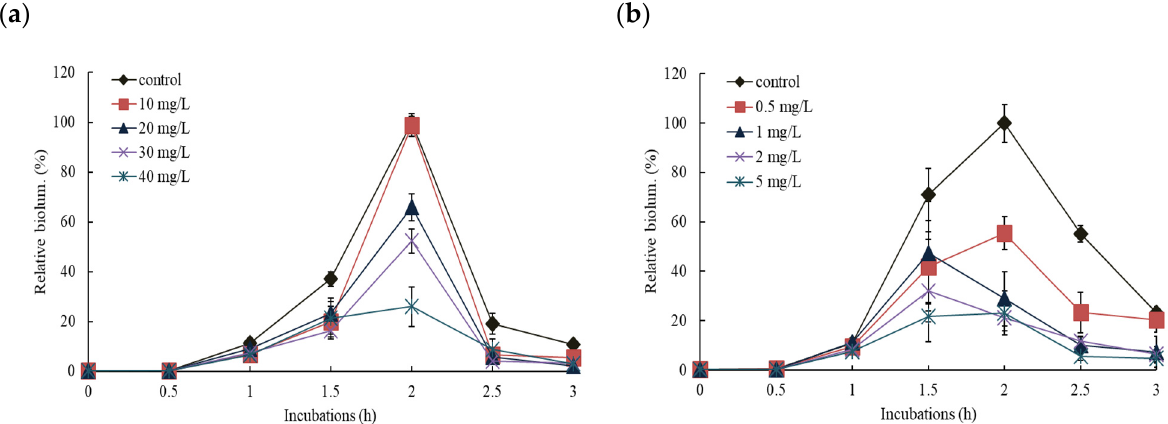
Figure 4. Effects of CuO and Al 2 O 3 NPs on the bioluminescence activity of KG1206 during 3 h incubation period, expressed by the relative activity of the maximum bioluminescence of the control: ( a ) 0–40 mg/L CuO exposure; ( b ) 0–3 mg/L Al 2 O 3 exposure.